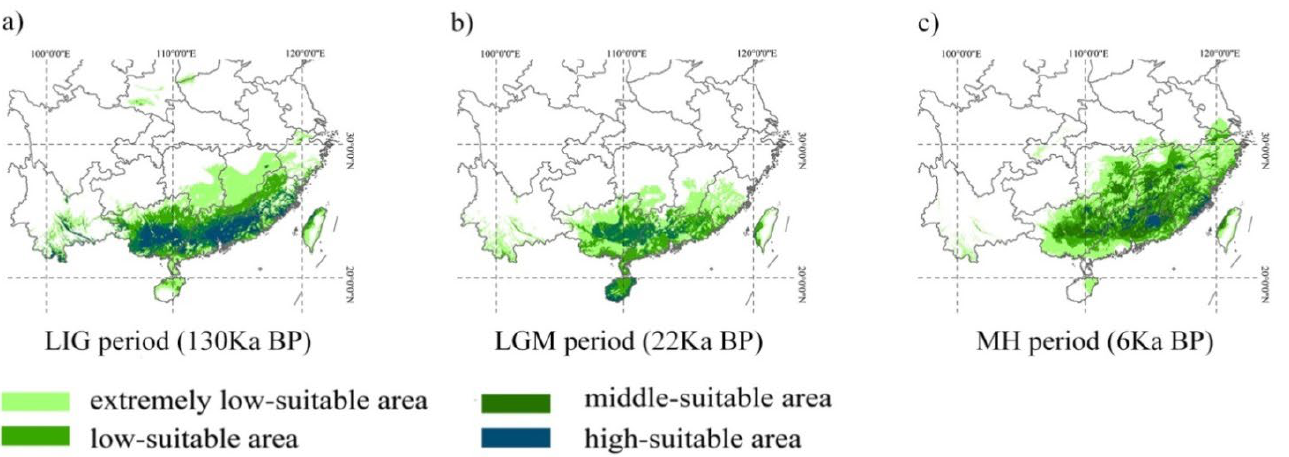
Figure 4. Potential distribution range of Castanopsis sclerophylla during the different periods, ( a ) the Last-interglacial (LIG, 130 Ka BP), ( b ) the Last Glacial Maximum (LGM, 22 Ka BP), ( c ) the Mid Holocene (MH, 6 Ka BP).